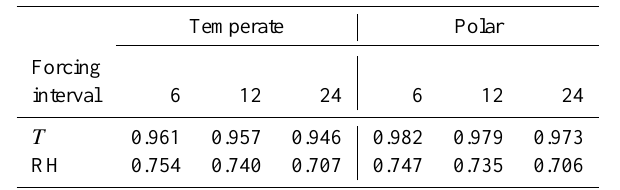
Table C1. Correlation coefficients for the three model runs forced by ERA-Interim against measurements, using 6-, 12- or 24-hourly boundary forcing for polar and temperate stations and both variables, T and RH.